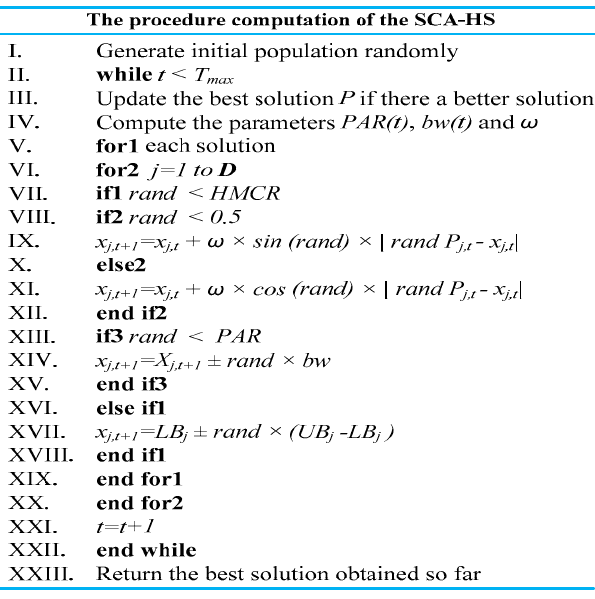
Figure 4. The pseudo-code of the proposed optimization algorithm.